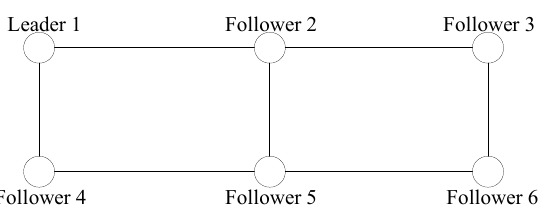
Figure 3. Graph G for six spacecraft in the Figure 3. Graph 𝒢 for six spacecraft in the swarm.